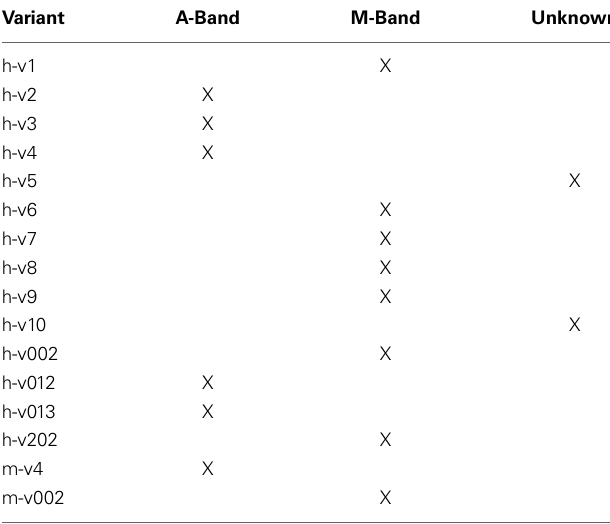
Table 4 | Sarcomeric localization of sMyBP-C